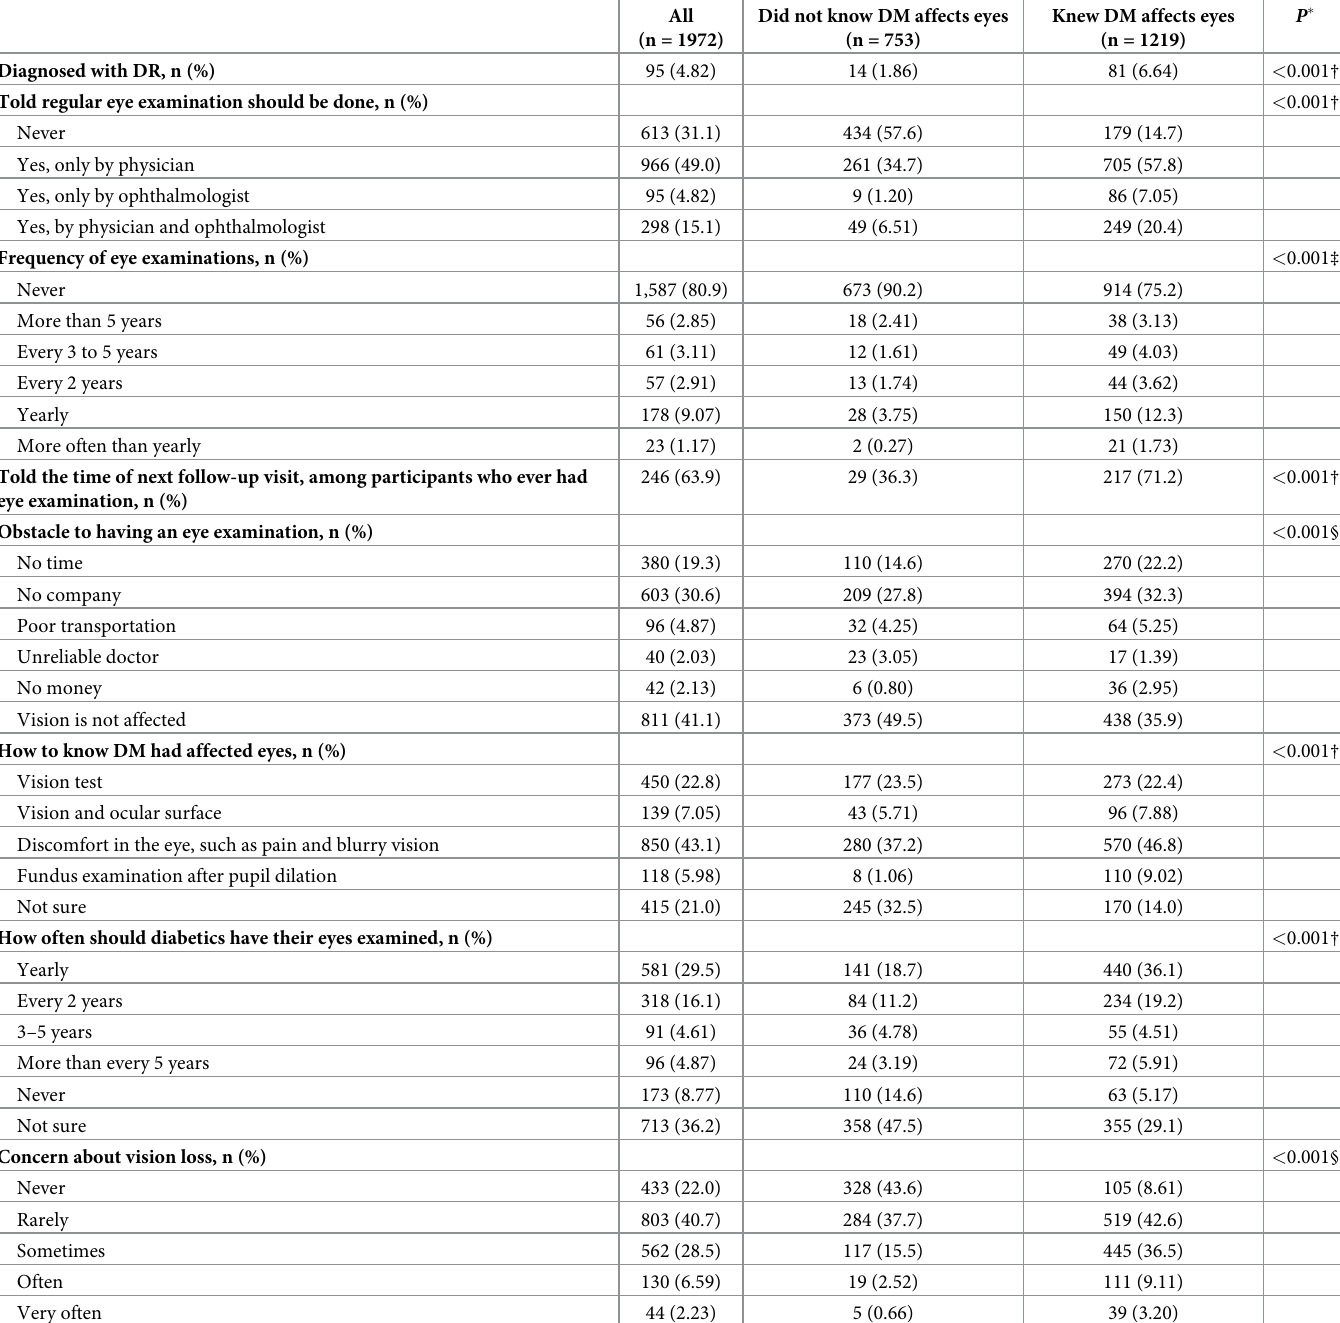
Table 3. History of ophthalmic care among diabetic patients by their knowledge of